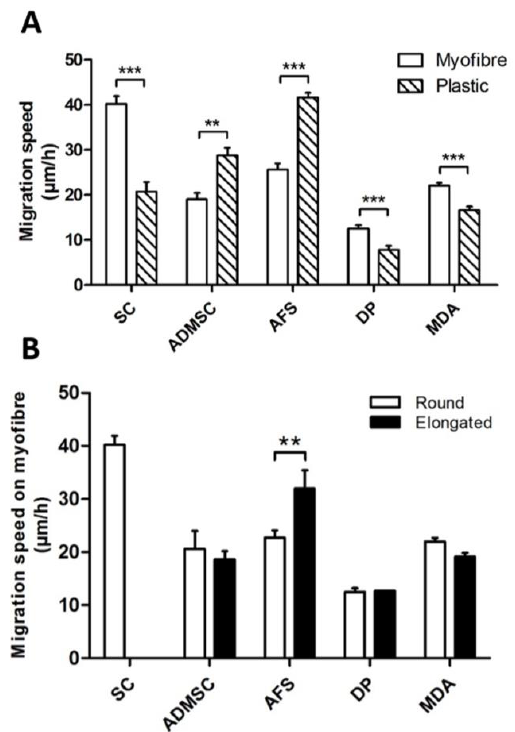
Figure 2. The skeletal muscle myofibre impacts on the migration speed of co-cultured non-muscle cells. ( A ) Cell migration speed comparison between plastic and myofibre substrates; ( B ) Migration speeds of differing morphologies of resident and non-muscle cells on myofibres. In all conditions n > 15 myofibres examined. Individual Student’s t -tests, ** p < 0.01, *** p < 0.001.